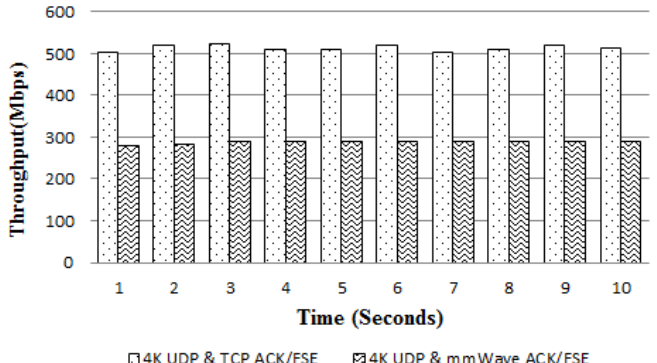
Figure 19. End-to-end throughput comparison between mmWave ACK and TCP ACK.